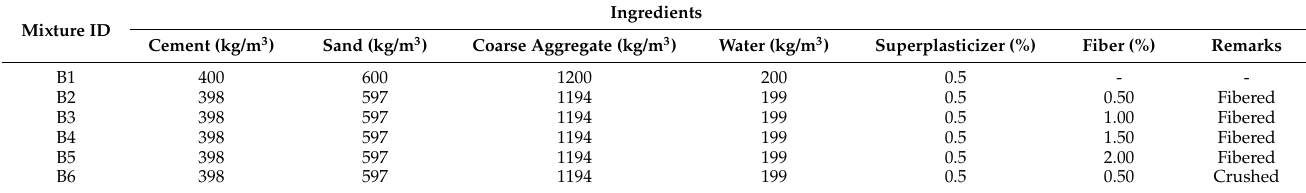
Table 1. Mix proportions of concrete with and without fiber